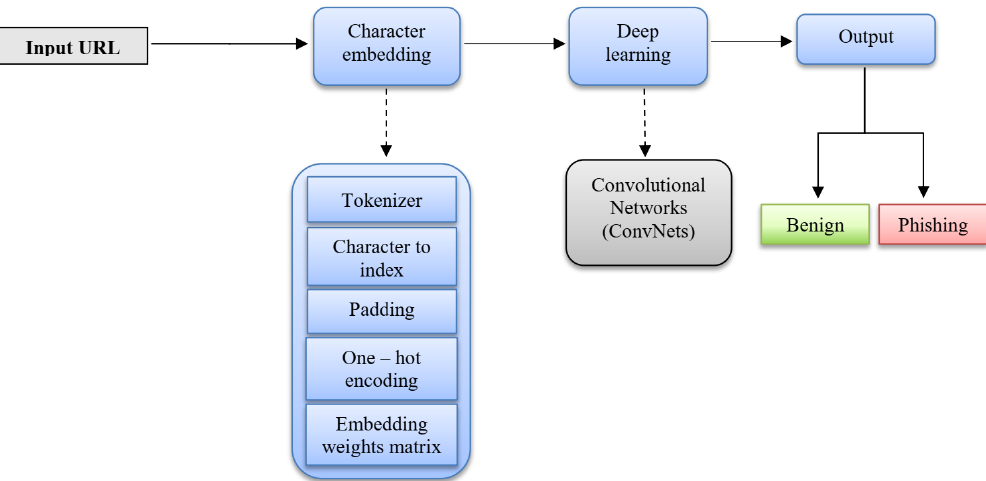
Figure 3. An overview of the proposed model.